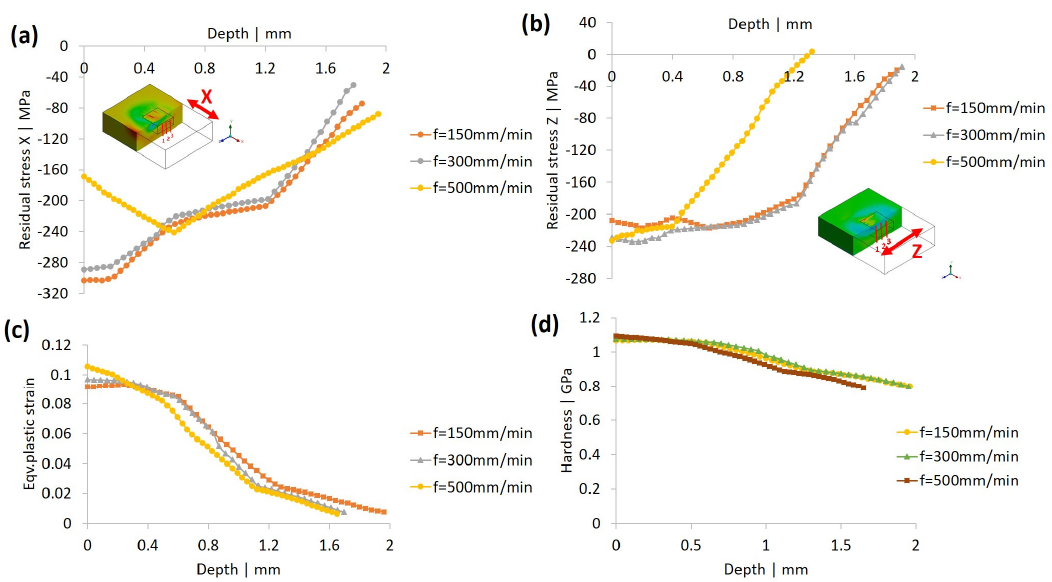
Figure 14. Effect of burnishing feed rate on ( a ) residual stress along the X (feed) direction; ( b ) residual stress along the Z (step-over) direction; ( c ) plastic strain, and ( d ) hardness, at F = 1650 N and S = 0.10 mm.